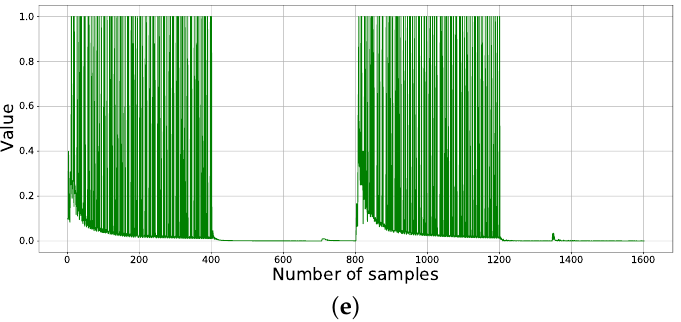
Figure 9. Feature values under normal and attack traffic: ( a ) speed of sessions; ( b ) speed of source IP; ( c ) standard deviation of flow packets; ( d ) standard deviation of flow bytes; ( e ) ratio of pair- flow entries.